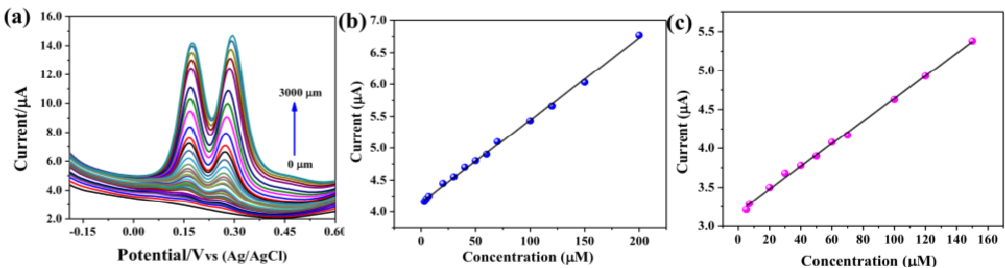
Figure 7. ( a ) DPV curves of CuS-CNF/GCE in 0.1 M PBS (pH = 5) containing different amounts of HQ and CC, ( b ) Current vs concentration of HQ and ( c ) Current vs concentration of CC.